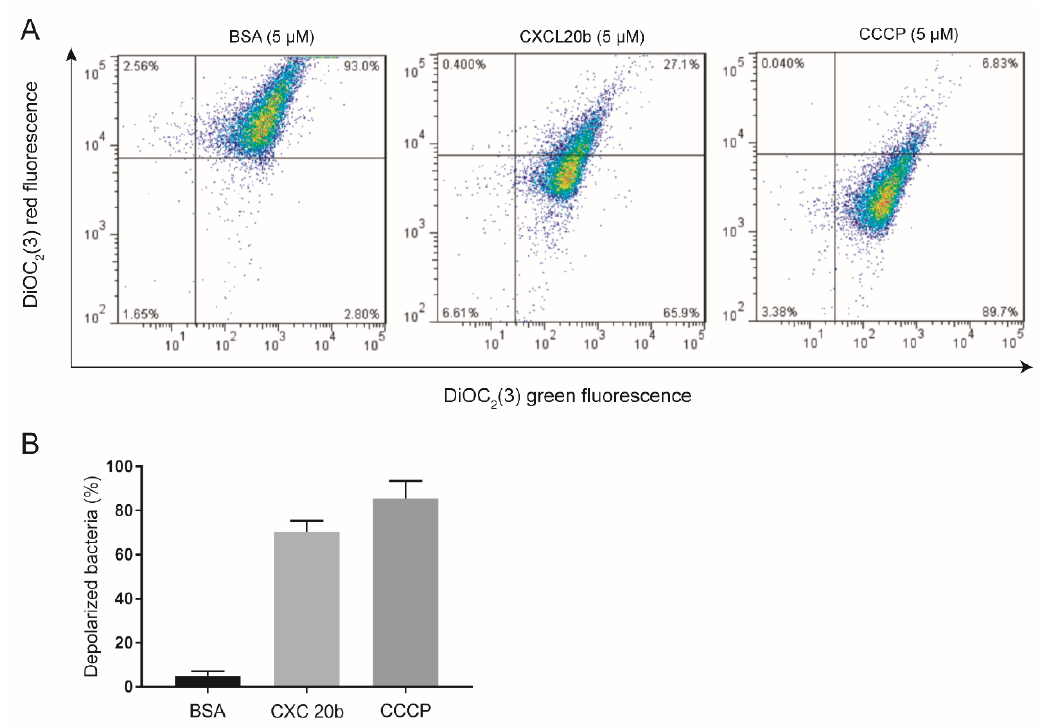
Figure 4. Grass carp CXCL20b destroys the integrity of bacterial cell membranes. ( A ) Flow-cytometry plots of 10,000 CFU S. aureus (ATCC 26923) incubated with 5 µM Bovine Serum Albumin (BSA; negative control), grass carp CXCL20b, and CCCP (positive control) using fluorescent dye DiOC 2 (3). ( B ) Normal and depolarized bacterial percentage of S. aureus (ATCC 26923) after treatment with 5 µM BSA, CXCL20b, and CCCP. Data from three independent experiments are shown (mean ± SEM).